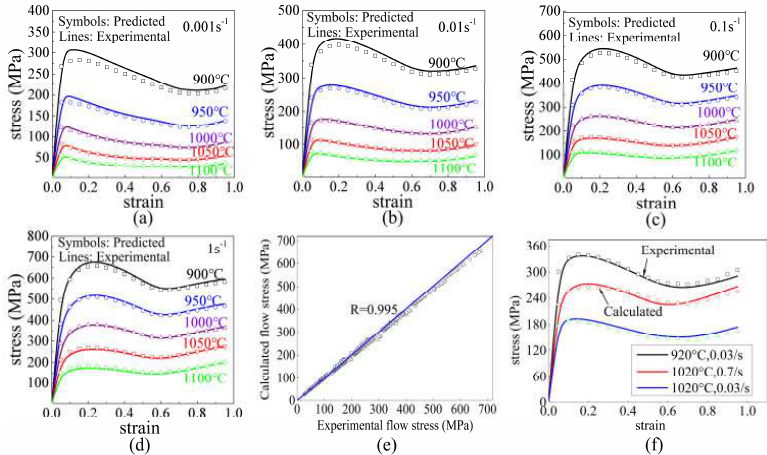
Figure 4. Comparison of predicted and experimental flow stresses of GH4169 compressed at various temperatures and strain rates of ( a ) 0.001 s −1 ; ( b ) 0.01 s −1 ; ( c ) 0.1 s −1 ; and ( d ) 1 s −1 ; ( e ) shows the scatter plot drawn by experimental and calculated flow stresses; ( f ) shows the validation of the model by three more experiments.